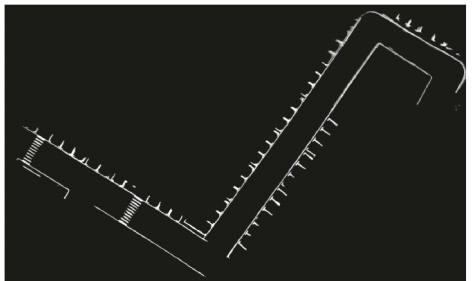
Figure 12: Global view of the matched area map within the local map.